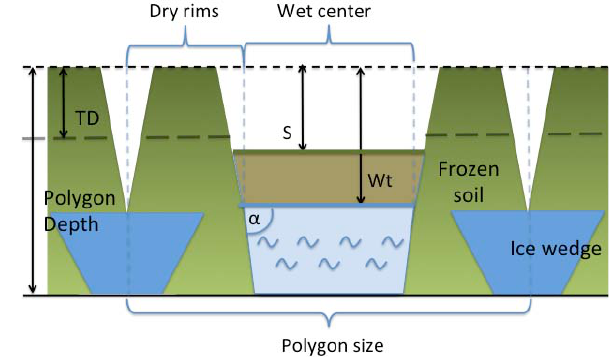
Fig. 3. Cross section of a polygon. Surface is divided in drier ele- vated rims and in lower wet centers. Both surface level and single polygon depth are randomly generated. Water table level W t and thaw depth TD are also randomly initialized, but they dynamically variate with external forcing ( W t ) and seasonal cycle (TD). Angle α represents the slope of polygon